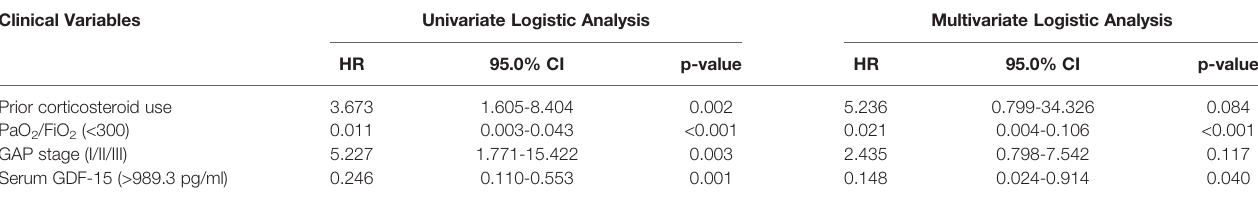
TABLE 3 | Risk factors for AE by logistic regression analysis in patients with IPF. Clinical